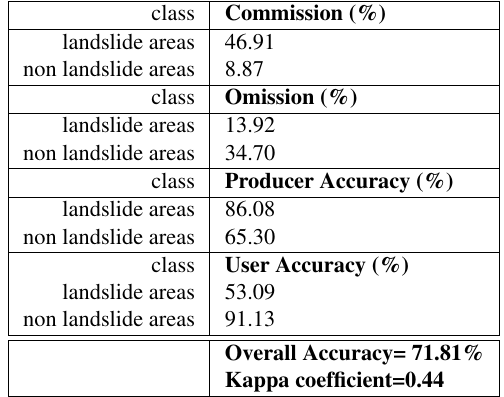
the landslide inventory map, the average user’s accuracy (UA),